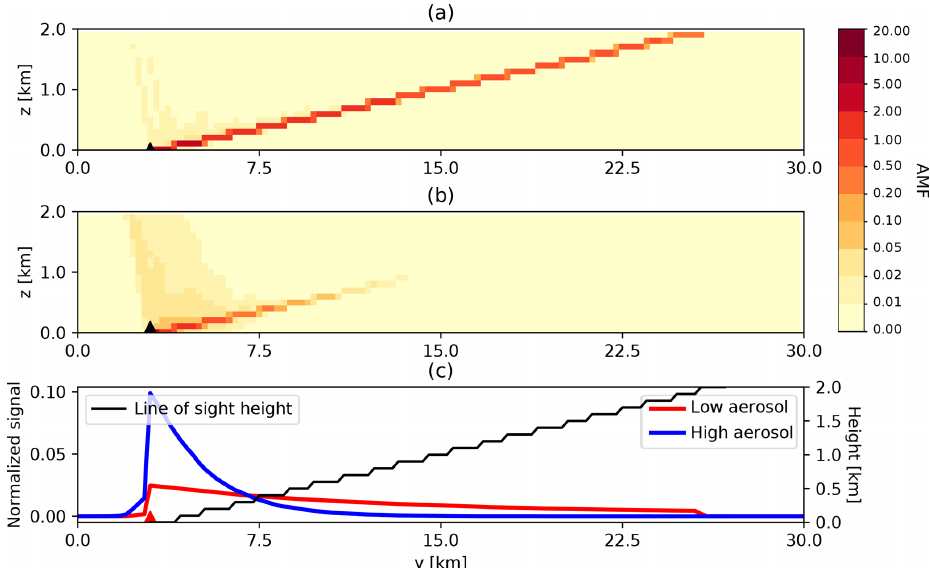
Figure 5. Cross section of 3D-box AMFs for a MAX-DOAS scenario with an instrument (black triangle) at the ground ( z = 0km, x = 20km, y = 3km) pointing northwards and slightly upwards at a viewing angle of 5 ◦ . The sun is at an azimuth angle of 344.7 ◦ and a zenith angle of 24.6 ◦ . The relative azimuth angle between sun and viewing direction is 164.7 ◦ . AMFs were simulated with two aerosol scenarios: a rural-type aerosol representative of spring–summer conditions in the aerosol layer (0–2km), with a visibility of (a) 50km and a visibility of (b) 10km and a background aerosol above 2km. Decay of vertically integrated AMFs with distance to the instrument is visualized (c) for the same scenarios with standard (red) and high aerosols (blue) as in panels (a) and (b) . The altitude of the line of sight as a function of distance is shown in